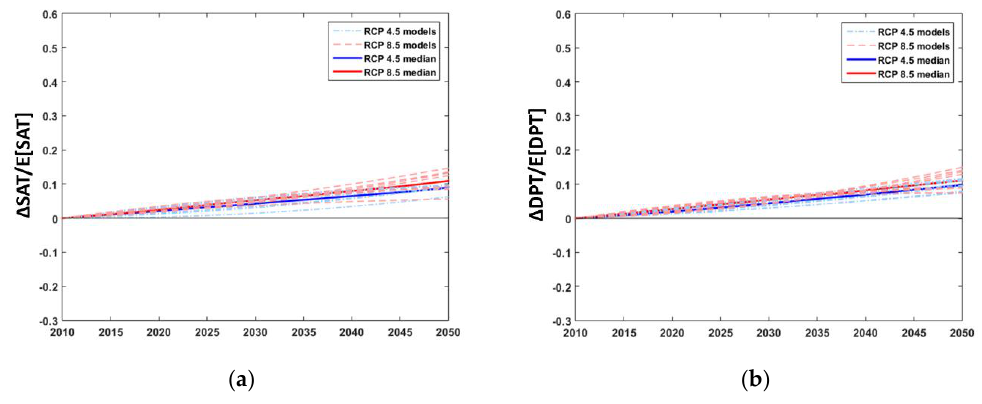
Figure 11. Trend analysis of SAT and DPT at Busan site.